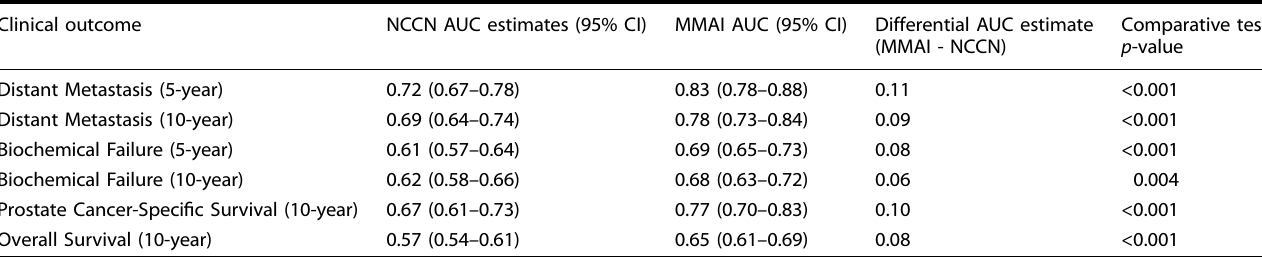
Table 2. Validation results for the subset of patients from the 20% validation set that includes patients with pretreatment slides only ( n = 931). Clinical